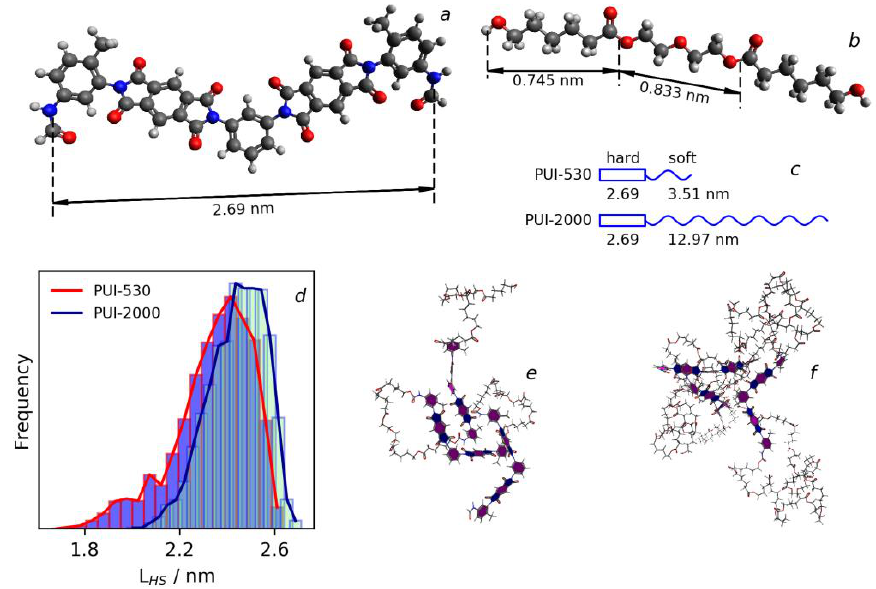
Figure 2. Chemical structure of the repeating unit of the hard segment ( a ) and soft segment ( b ); length of hard and soft segments of block copolymers ( c ); distribution of end-to-end distance of hard segment for macromolecules in solution at 30 °C ( d ); macromolecules of PUI-530 ( e ) and PUI-2000 ( f ), containing three repeating hard-soft blocks after a molecular dynamics simulation in solution.